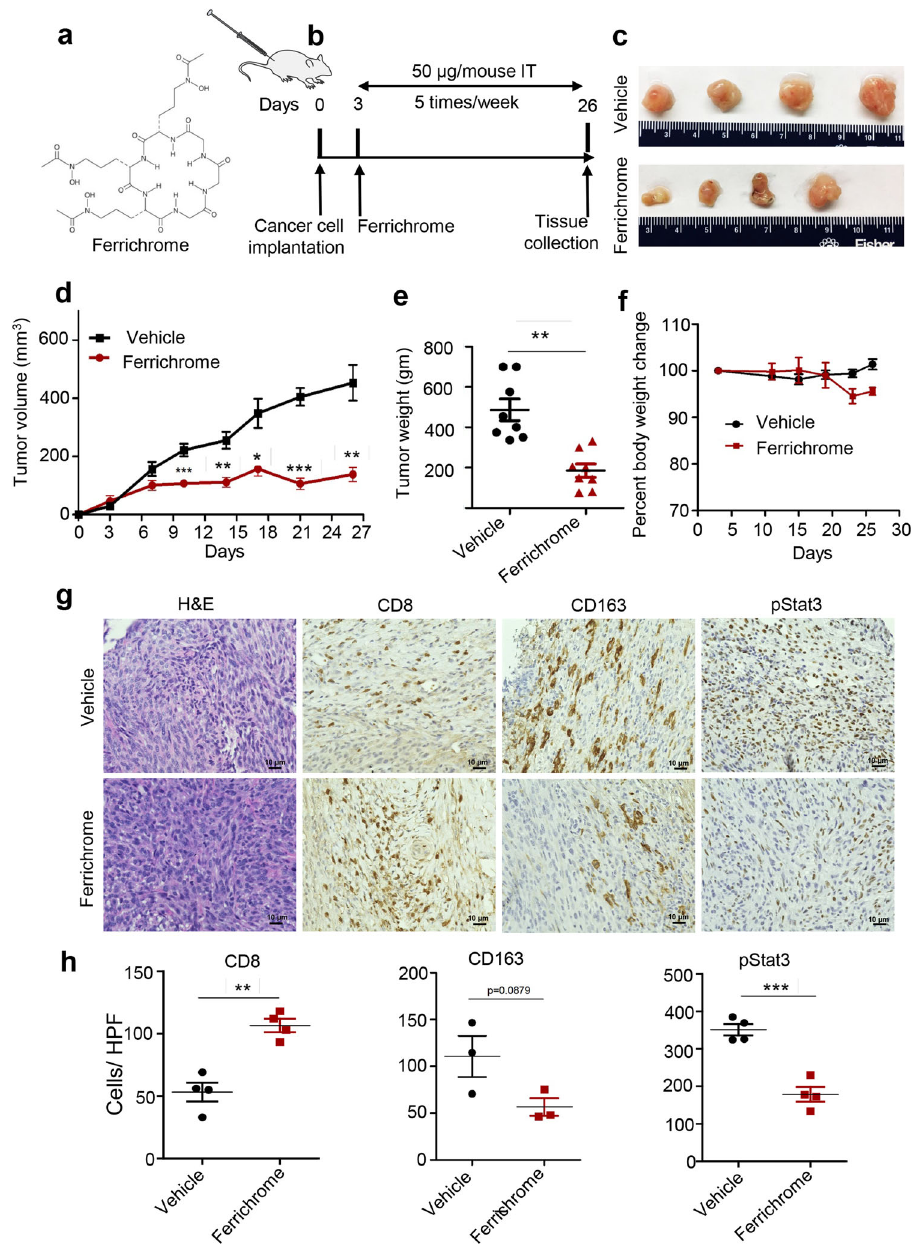
Fig. 1 Ferrichrome suppresses tumor growth and promotes antitumor immunity in a pancreatic cancer syngeneic mouse model. a Chemical structure of ferrichrome (iron free) (deferrichrome). b Schematic representation of ferrichrome treatment regimen of UN-KC-6141 cells derived syngeneic mouse model of pancreatic cancer. One million syngenetic UN-KC-6141 pancreatic cancer cells were subcutaneously injected into the right fl ank of C57BL/6J mice ( n = 8). Ferrichrome was given fi ve times per week intratumorally (50 µ M) until day 25. Vehicle consisted of equivalent volume of 1X PBS. Mice were sacri fi ced at day 26. c Representative pictures of tumors resected at day 26 from ferrichrome or vehicle-treated mice. d The volumes of ferrichrome- and vehicle-treated tumors ( n = 8). e Wet weights of UN-KC-6141 tumors treated with ferrichrome or vehicle ( n = 8). f Body weights of mice treated with ferrichrome or vehicle ( n = 5 – 8). g Representative H&E and immunohistochemistry images of, CD8, CD163 and pStat3 staining ( n = 3 – 4), Original Magni fi cations ×400 ( h ) Quanti fi cation of CD8, CD163 and pStat3 positive cells per high power fi eld in ferrichrome (maroon) or vehicle-treated tumors (black) ( n = 3 – 4). Mean ± SEM shown. * p < 0.05, ** p < 0.01, *** and p < 0.001, as determined by Student ’ s t